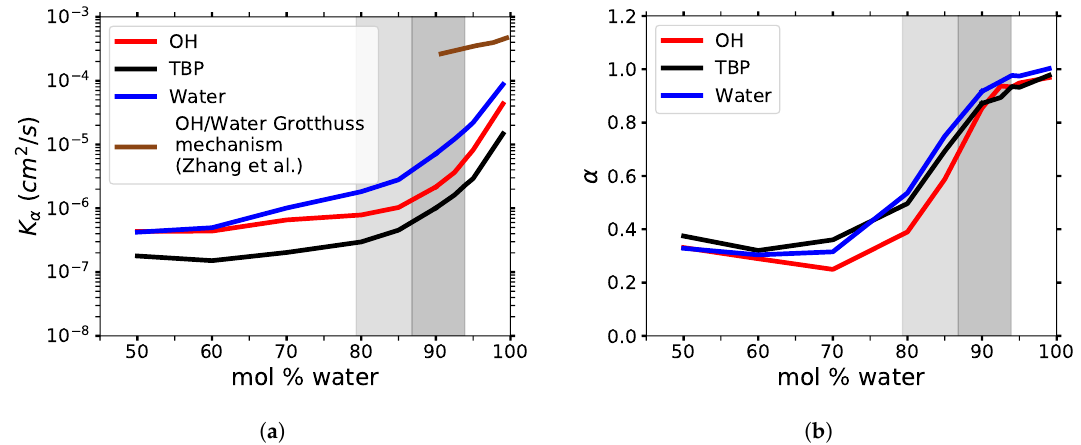
Figure 16. Anomalous diffusion coefficients in TBPH–water at p = 1atm and T = 300K as a function of water concentration: ( a ) generalized diffusion coefficient, K α ; ( b ) anomalous diffusion exponent, α . The Grotthuss mechanism ReaxFF data was fitted to the anomalous diffusion equation with an assumed α value of 1 (original data from Zhang et al. [56]). Table 3. TBPH anomalous diffusion coefficients of water, TBP + , and OH – .